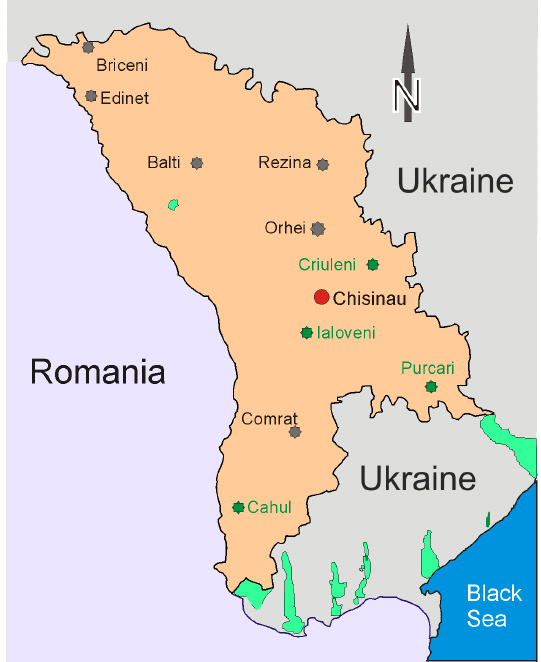
Figure 1. The geographical location of the sampling points (green